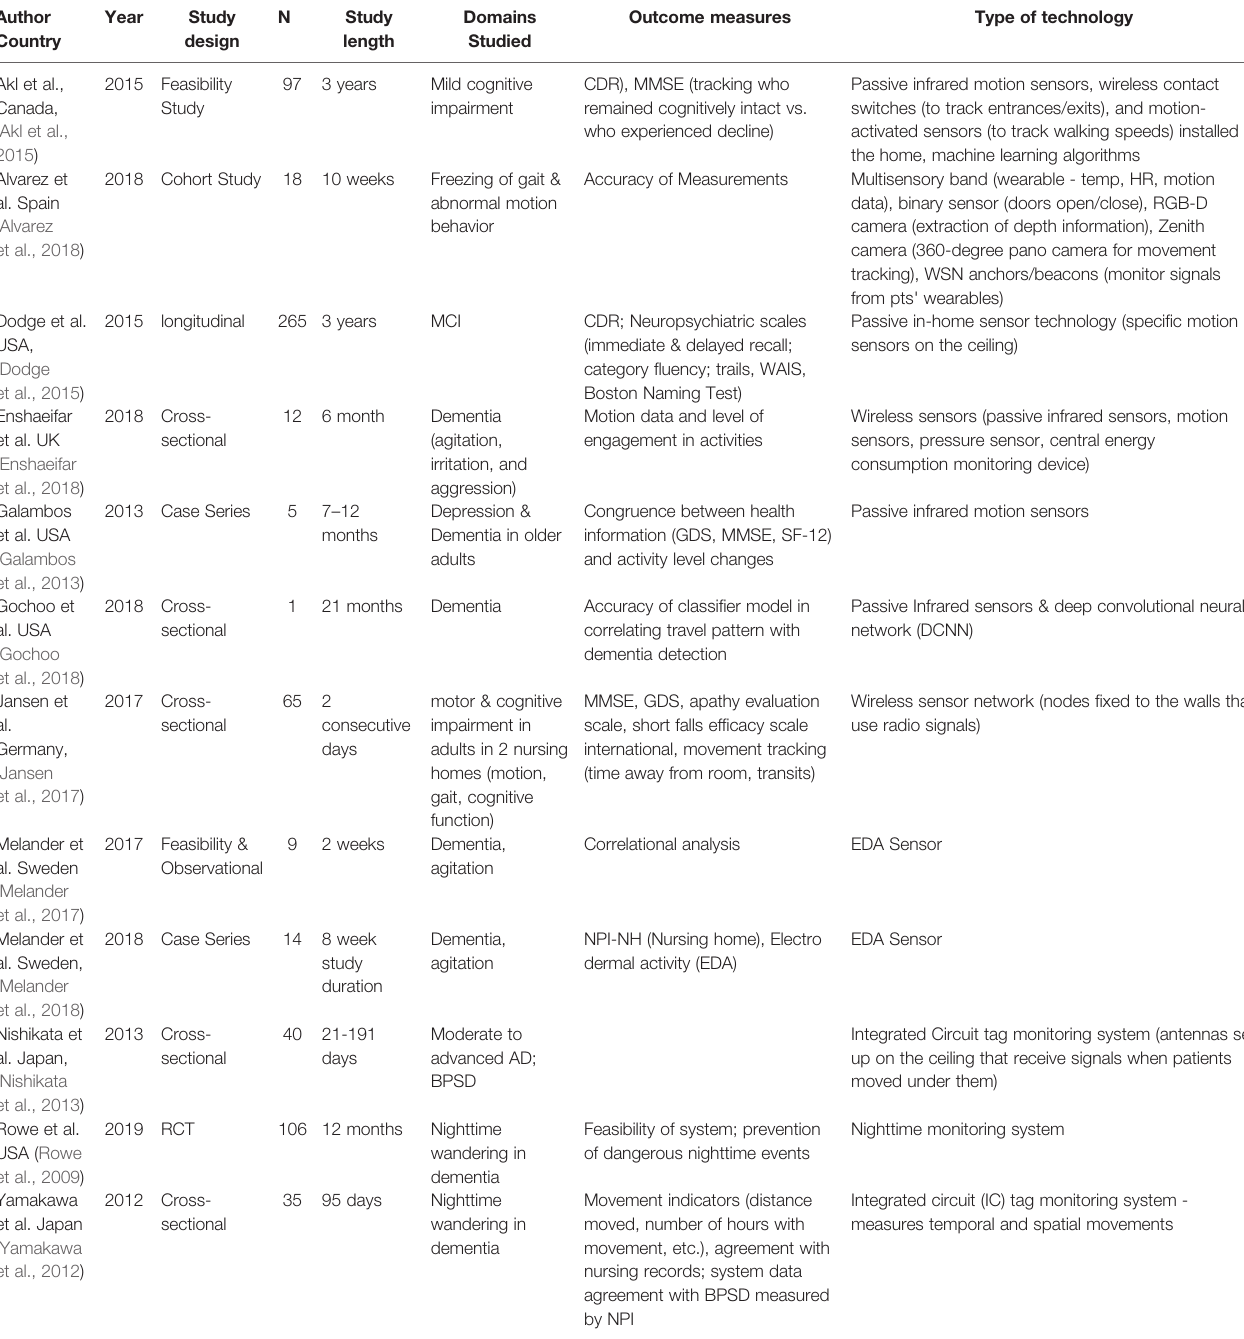
TABLE 3 | Studies utilizing motion-sensing